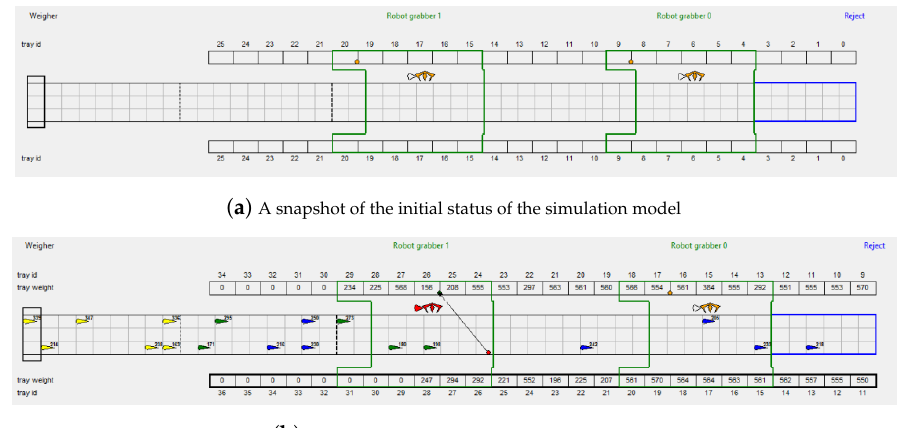
Figure 5. A snapshot of the implemented simulation